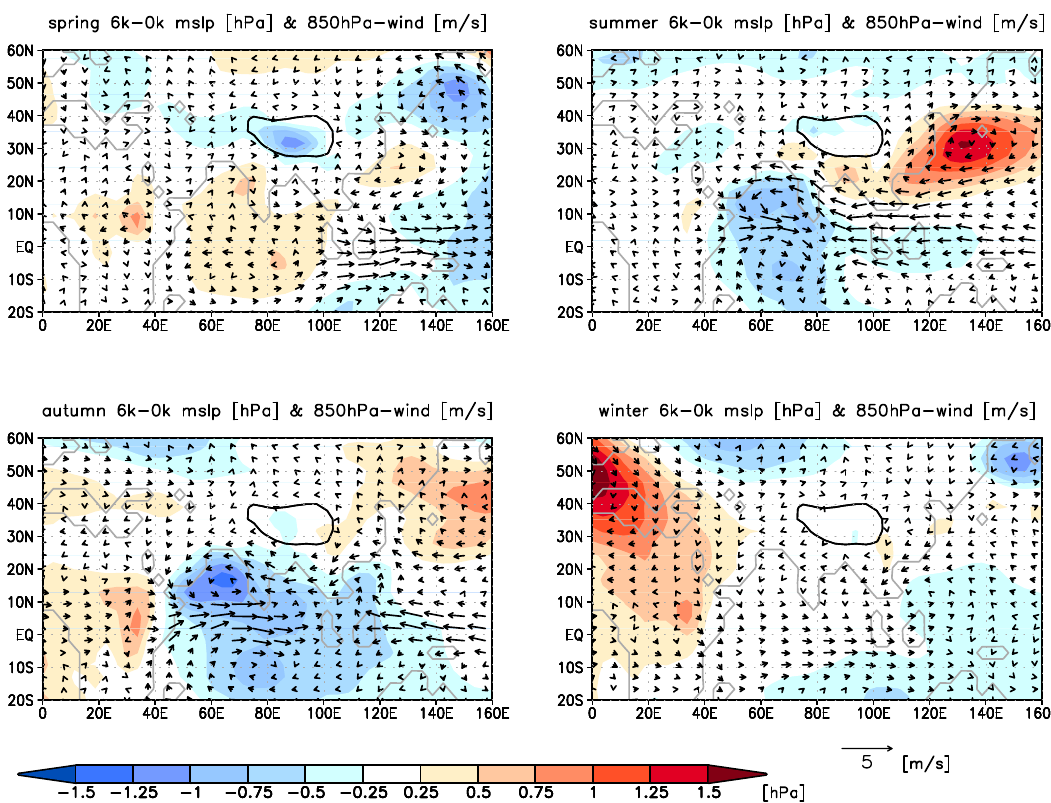
Fig. 11. Same as Fig. 9, but for the differences in wind and pressure field attributed to the ocean-atmosphere